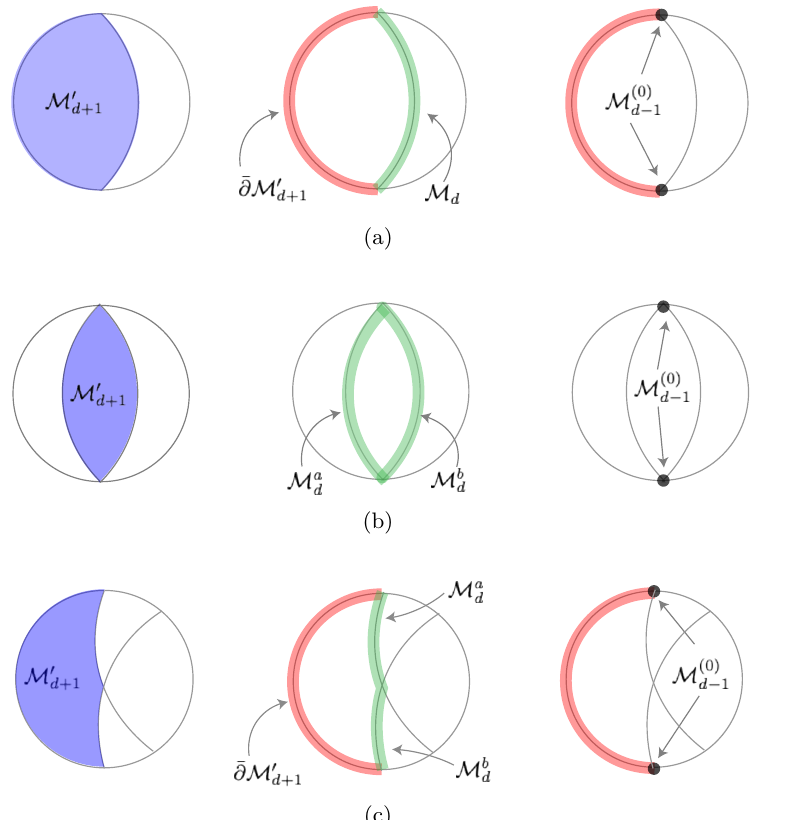
Figure 6 . Double holography in global patch with (a) one Karch-Randall brane, (b) two Karch- Randall branes with coinciding endpoints, and (c) two Karch-Randall branes with spatially sepa- rated endpoints. The blue shaded regions M 0 contain a gravitational theory living on a part d +1 of an asymptotically AdS space. The red lines represent CFTs on their asymptotic boundaries ¯ . The green lines M , M a , and M b are (parts of) Karch-Randall branes hosting a UV- ∂ M 0 d d +1 d d cutoff CFT coupled to gravity. The black dots M (0) are CFTs on the asymptotic boundaries of d − 1 the branes, implemented as boundary conditions of the higher-dimensional CFTs. In each case all three descriptions are mutually holographically dual. In this illustration we assume that the brane tensions are positive in (a) and (b) but negative in (c). The reason for choosing negative brane tension for (c) will be made clear in the next